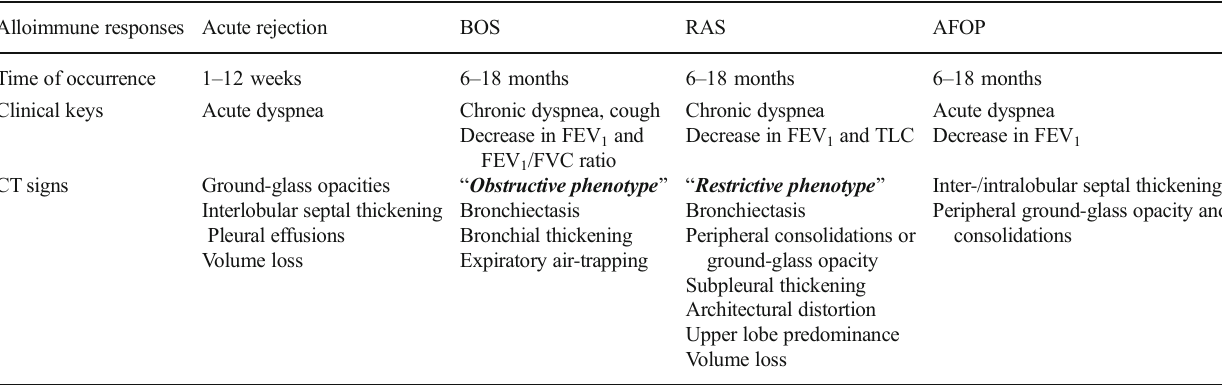
Specific CT pattern with alloimmune